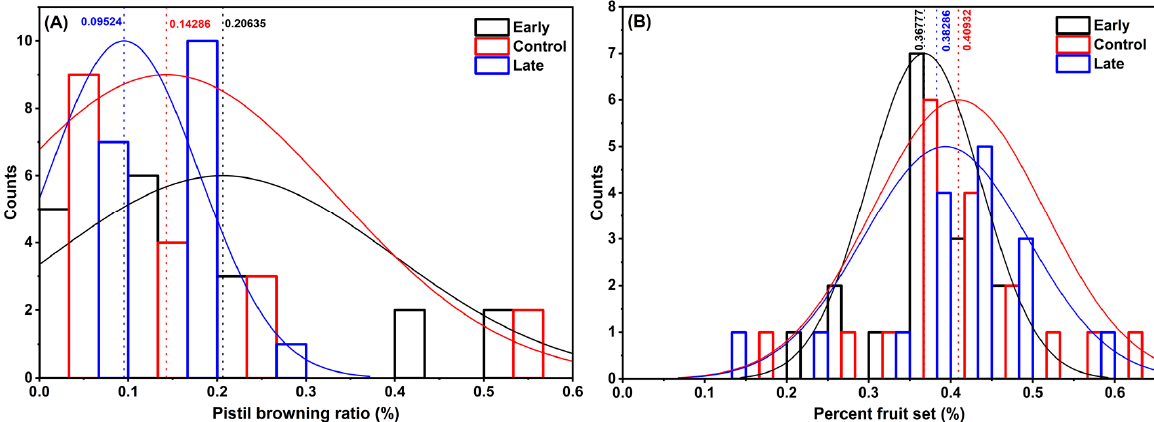
Figure 3. Impacts of FAME on ( A ) pistil browning ratio and ( B ) percent fruit set of ‘Lapins’ sweet cherry in the spring of 2019 at SuRDC1. The early spray (Early) and the late spray (Late) were applied on 7 March and 1 April, respectively. Solid lines in the histograms are distribution curves (n = 18 trees per treatment). Vertical dot lines stand for the mean for each data group.